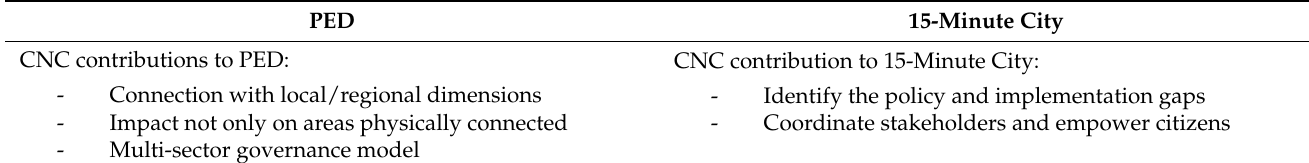
Table 8. Interface of Climate-Neutral Cities with two DUT